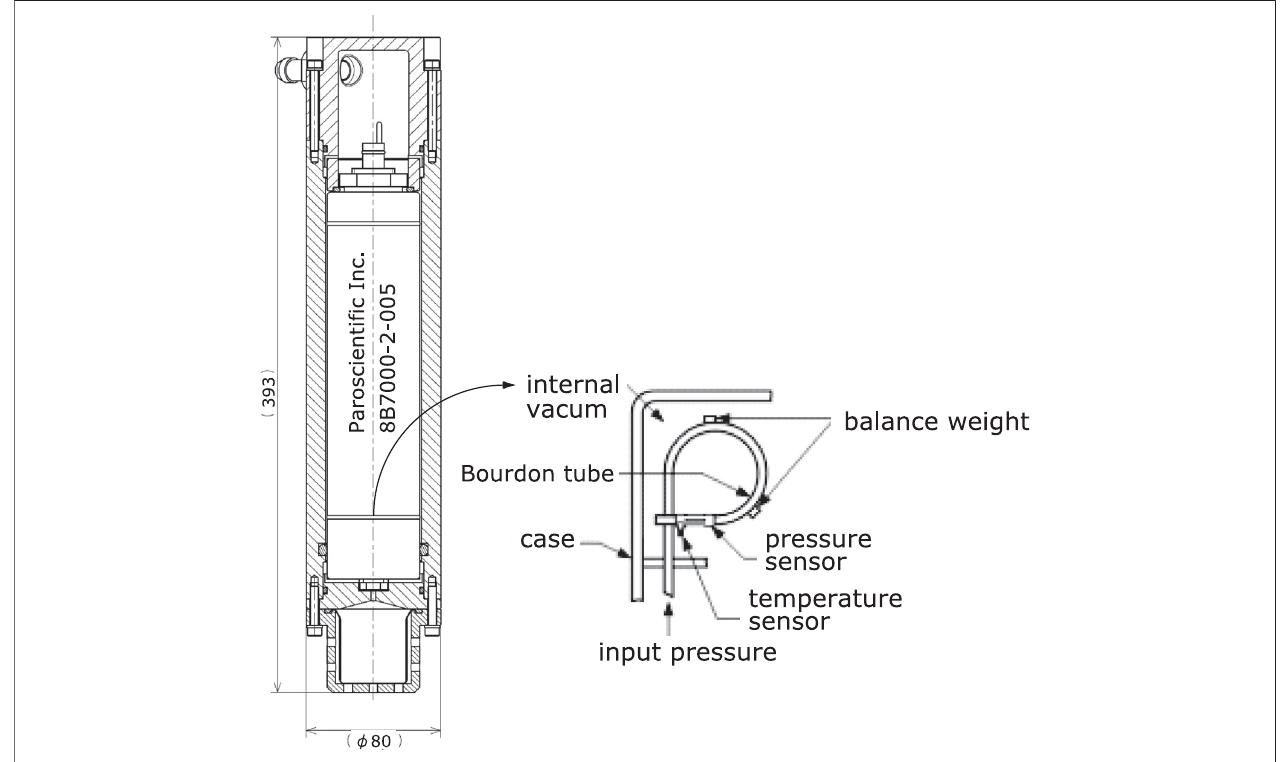
FIGURE 2 | Schematics of the oil fi lled pressure sensor (left) designed for DONET and internal mechanism (right) , courtesy of Paroscienti fi c, Inc.